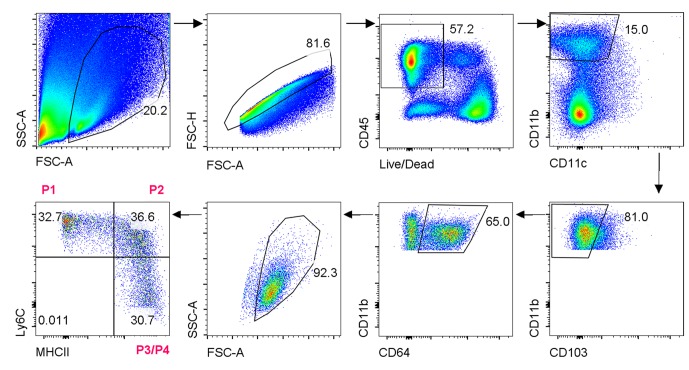
Gating strategy for colonic lamina propria macrophages.